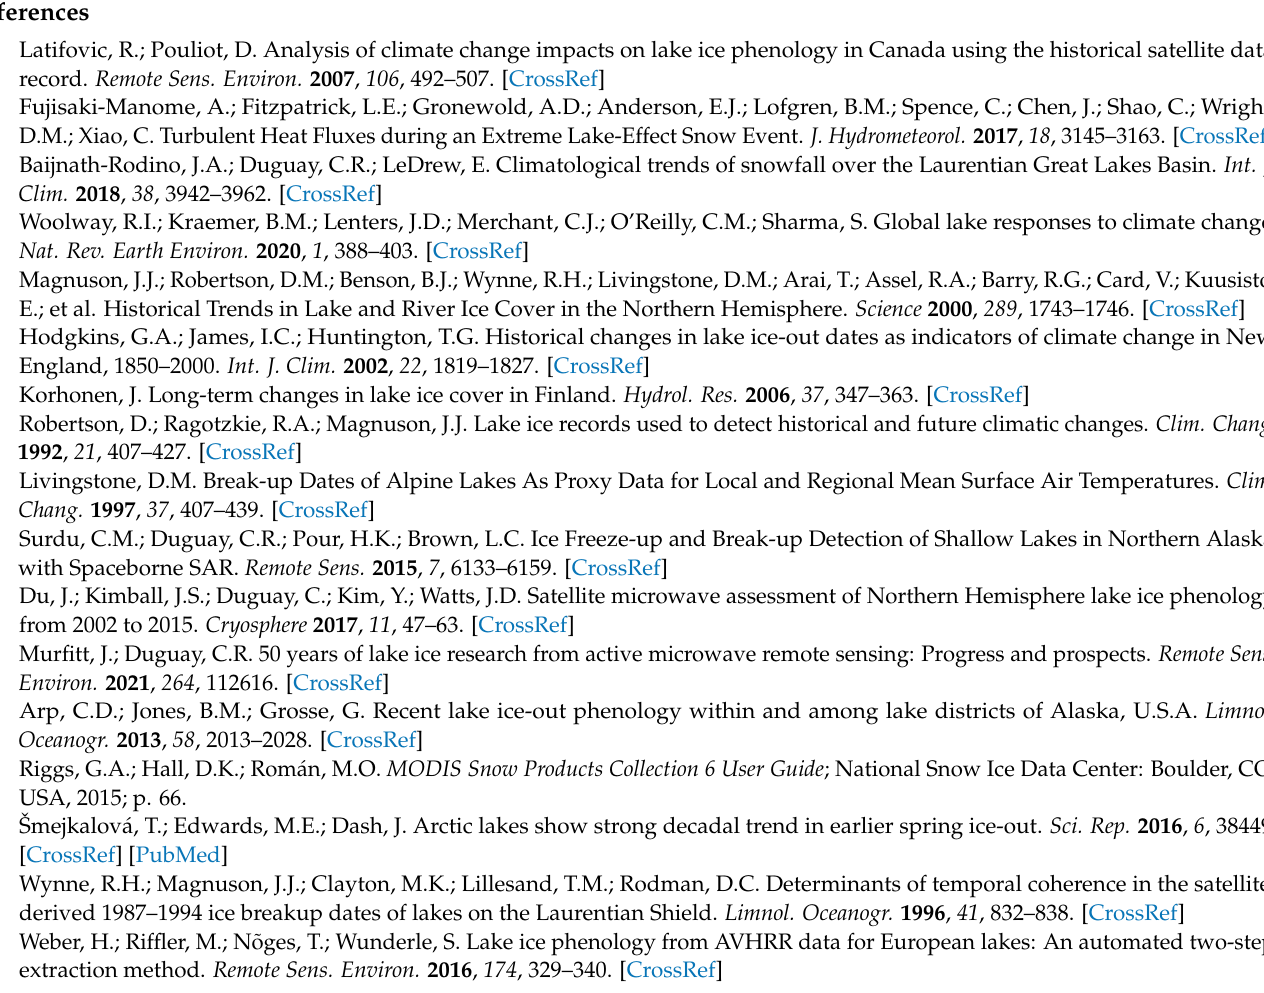
the western pixel. Table S5: Lake ice phenology parameters during 2002 to 2021 in Nam Co